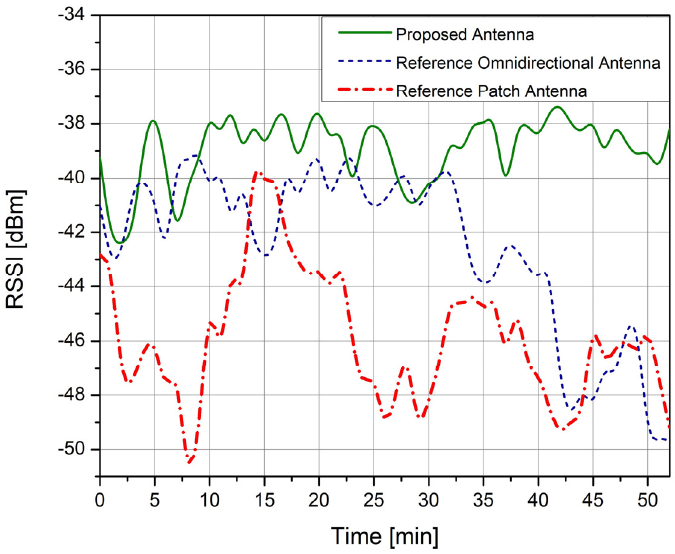
Figure 16. RSSI parameter variation obtained in the real operating scenario.